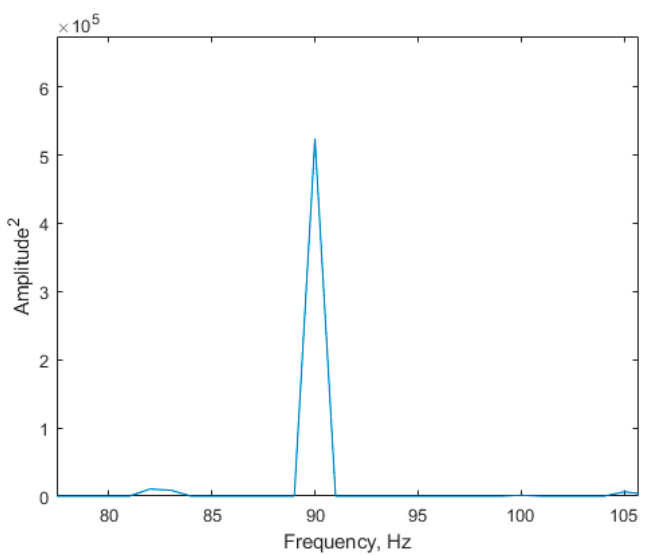
Figure 20. Amplitude spectrum of a faulty asynchronous motor in steady state built with NC technique.